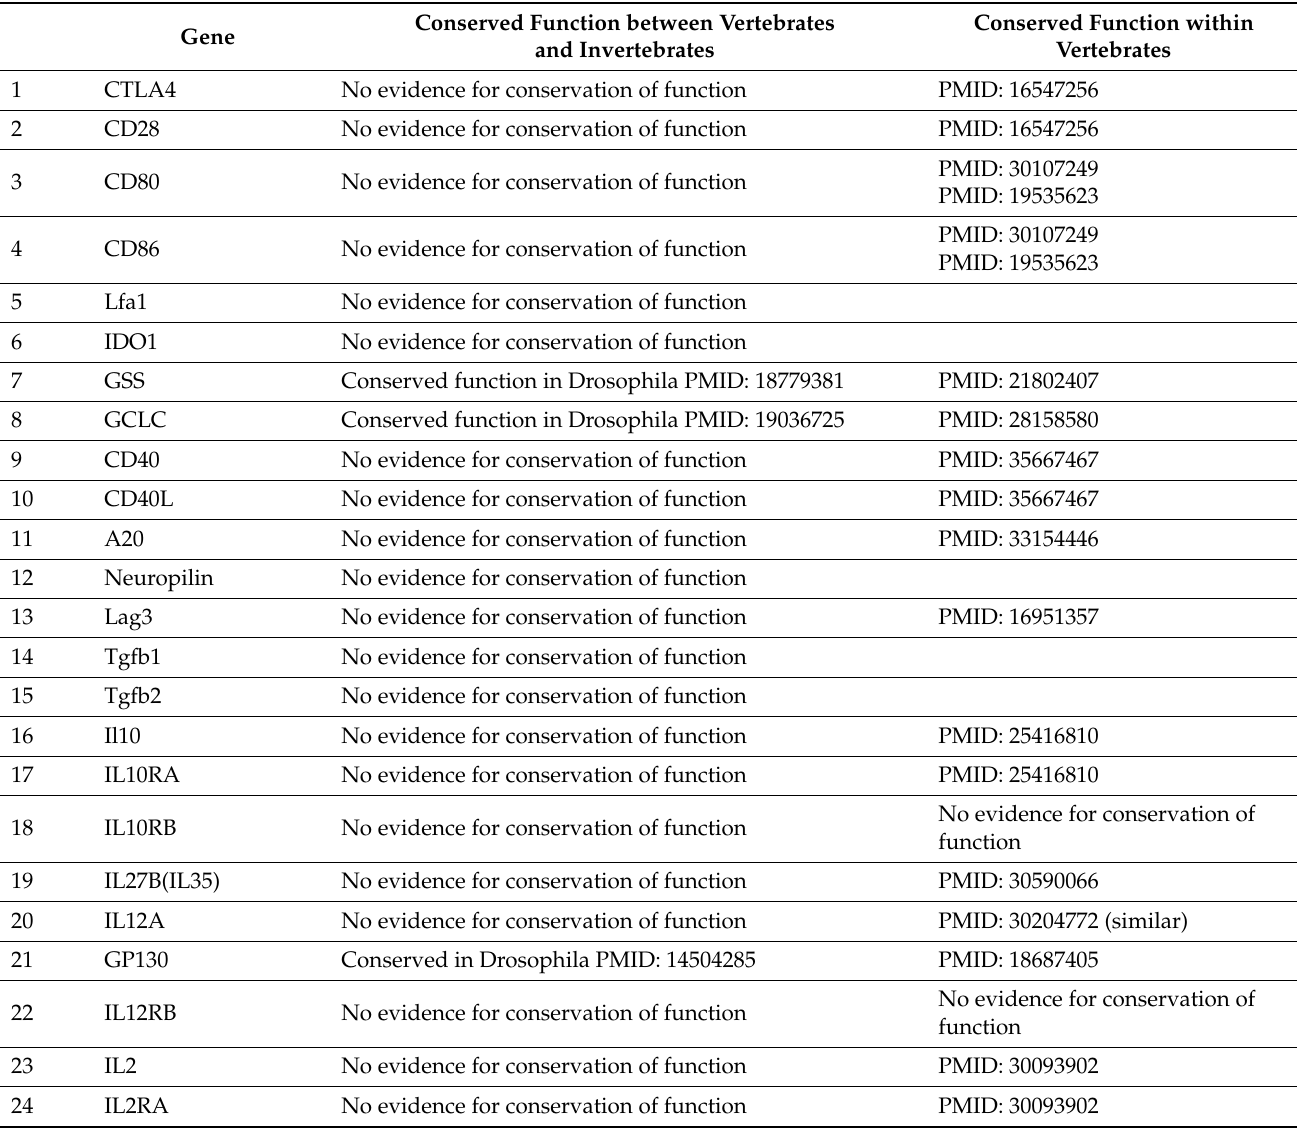
Table 2. Experimentally validated conservation of function for Treg suppressor